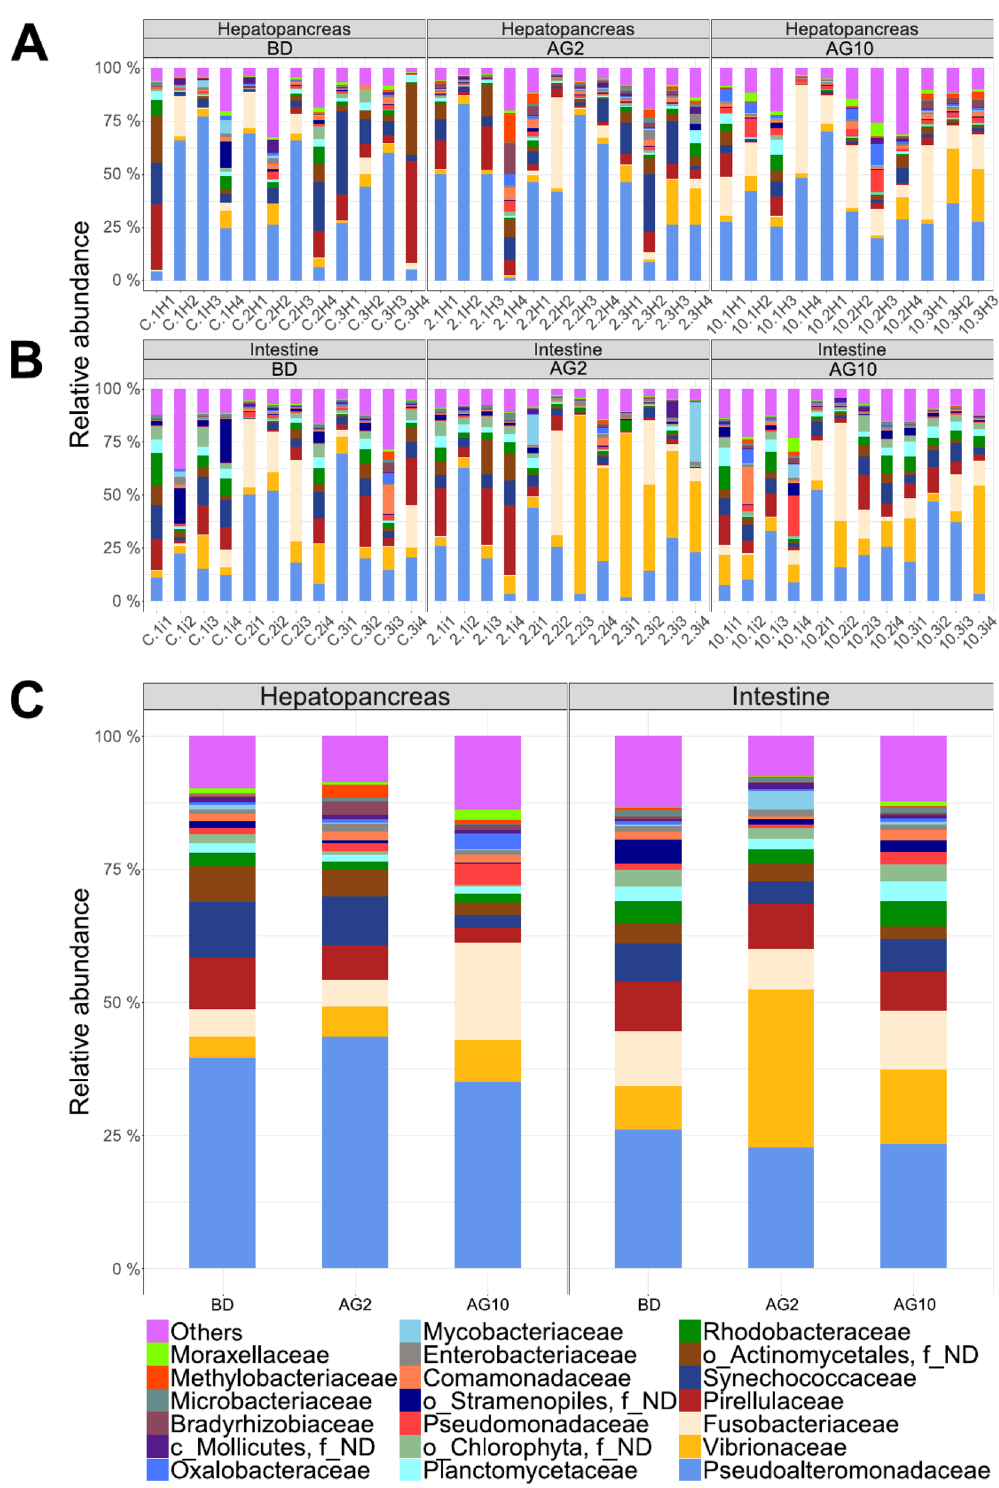
Figure 3. Taxonomic diversity and abundance of all 35 sequenced samples at family level. The Stacked-bar plot represents the relative abundance for ( A ) hepatopancreas and ( B ) intestine samples. ( C ) Relative abundance in the hepatopancreas and intestine for treatment. Only the top 20 is shown; the sum of the remaining taxonomic groups is indicated as